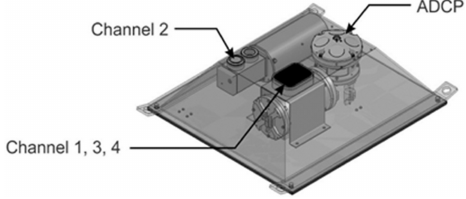
Figure 1. The deployed instrument package showing the locations of the multifrequency SWIPS and ADCP current profiler including the locations of the SWIPS transceivers.